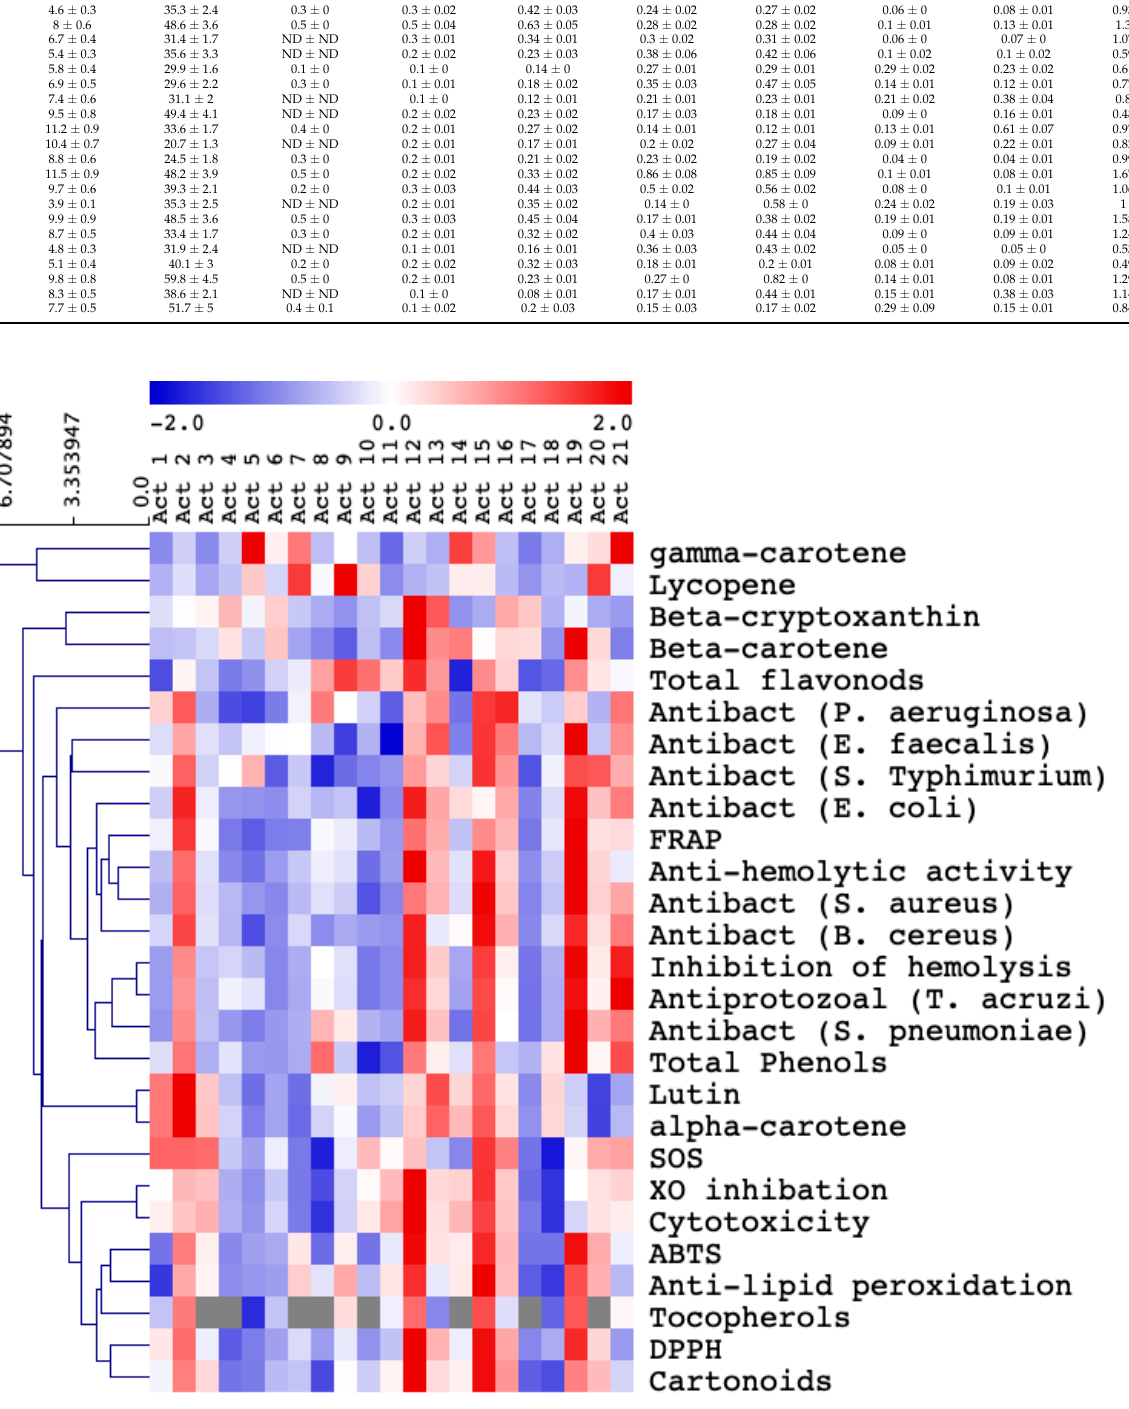
Figure 2. Hierarchical clustering (Pearson correlation) was generated to study bioactivity of several bacterial isolates. The measured parameters are represented by antioxidant metabolites and enzymes, overall antioxidant capacity (FRAP, DPPH, ABTS, SOS and XO inhibition), anti-hemolytic and anti-lipid peroxidation as well as their antibacterial and antiprotozoal activity. Data are represented by the means of at least three replicates. Table 2. The antioxidant, anti-hemolytic, cytotoxicity and antiprotozoal activity of 21 actinobacterial isolates. Data are represented by the means of at least 3 replicates ± standard deviations (SD).